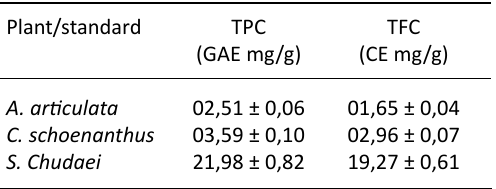
Table 3. Total phenolic and flavonoid content of plant extracts Plant/standard